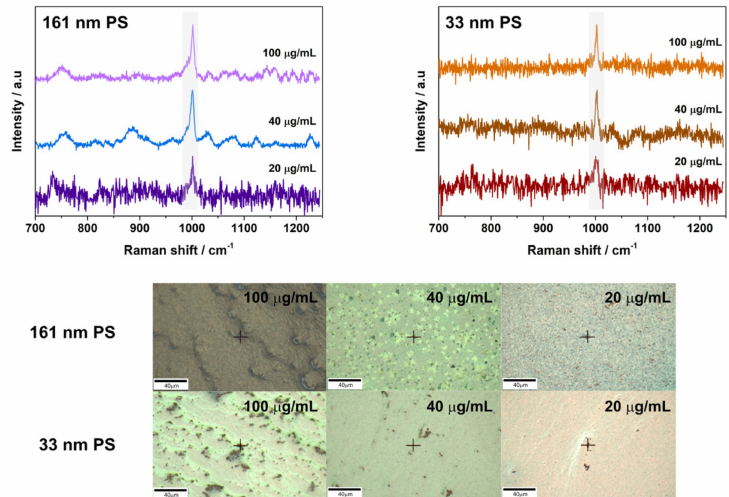
Figure 2. SERS spectra obtained for 161 nm PS particles on 46 nm AuNP substrates ( top ) and 33 nm PS nanoparticles on 46 nm AuNP substrates ( bottom ). Spectrum obtained are shown above images of the region of interest (ROI) the measurement was obtained from. Scale for all is 40 µ m. Laser power, scan speeds, and number of averaged accumulations for the samples can be viewed in Table A1.